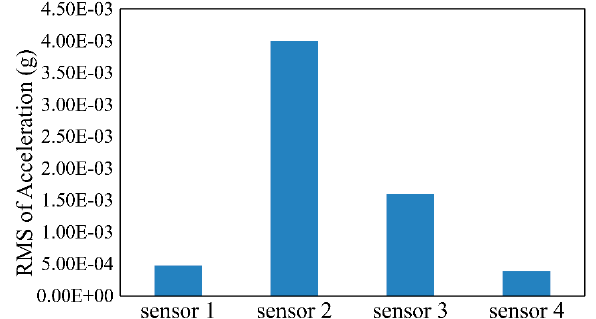
Figure 5. Root mean square (RMS) of sensor acceleration.